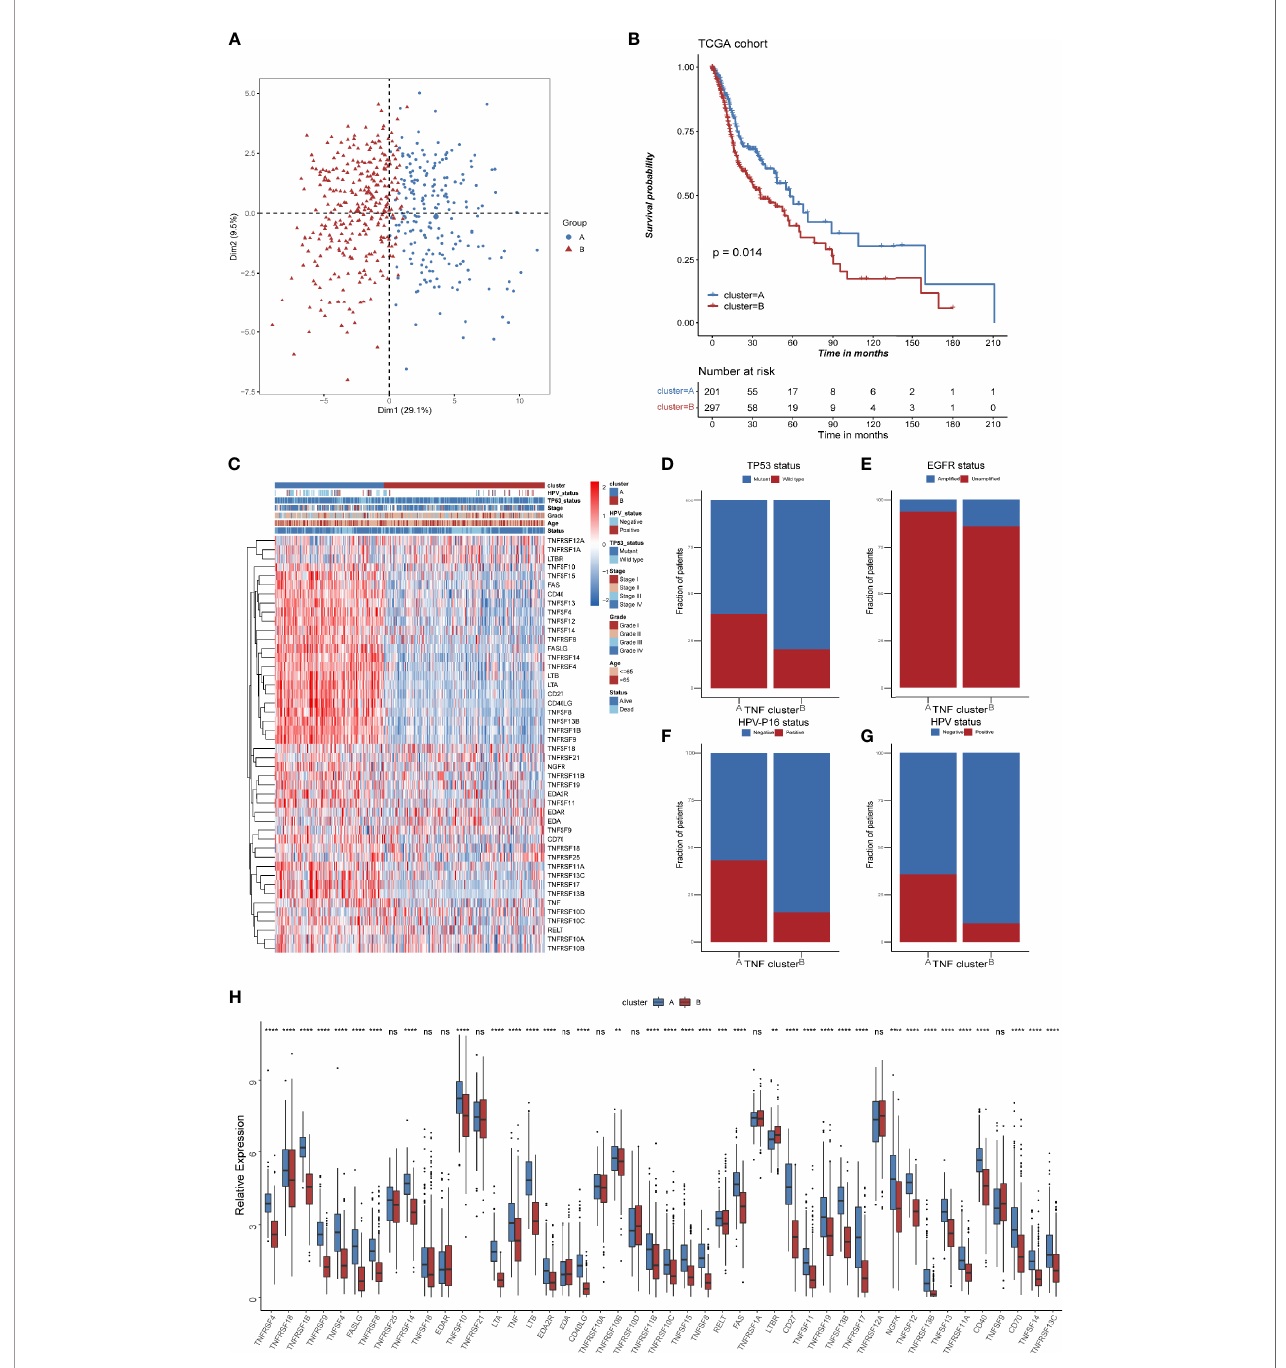
FIGURE 3 | TNF patterns in the TCGA HNSCC cohort. (A) Principal component analysis (PCA) for the expression of 46 TNF/TNFR proteins to distinguish two TNF/ TNRER patterns in TCGA HSNC cohort. (B) Kaplan-Meier survival analysis of two TNF patterns in TCGA HNSCC cohort. (C) Unsupervised clustering of 46 TNF family proteins in TCGA HNSCC cohort. Red represents high expression, and blue represents low expression. The TNF patterns, HPV status, TP53 status, stage, pathological grade, age, and survival status were used as sample annotations. (D – G) Stacked bar plot of TCGA HNSCC TP53 status, HPV-16 status, HPV status and EGFR status in two TNF patterns, respectively. (H) Relative expression of 46 TNF family proteins in TNF cluster A and B in TCGA HNSCC cohort. (** p < 0.01, *** p < 0.001, **** p < 0.0001, ns, not signi fi